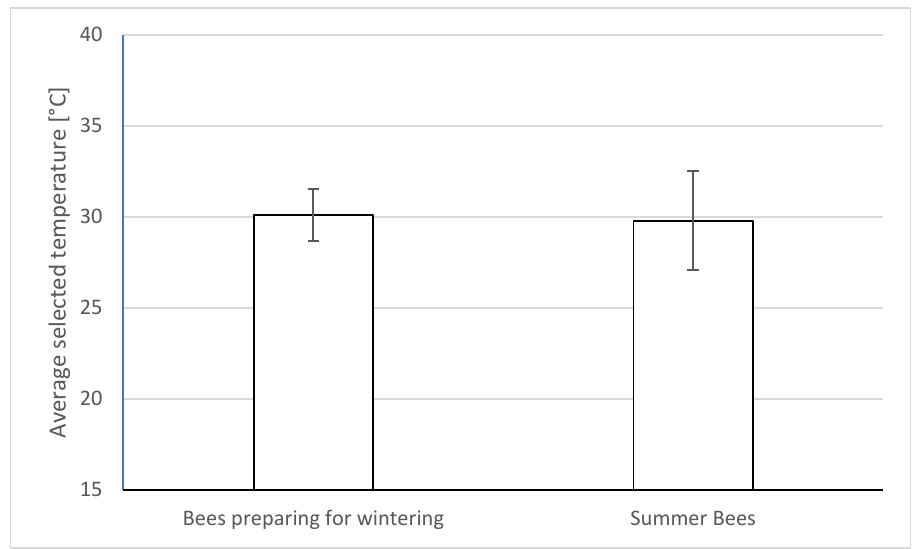
Figure 5. Differences between average temperatures [°C] selected by worker bees from the following subspecies: Caucasian honeybee, Carniolan honeybee and Central European honeybee.